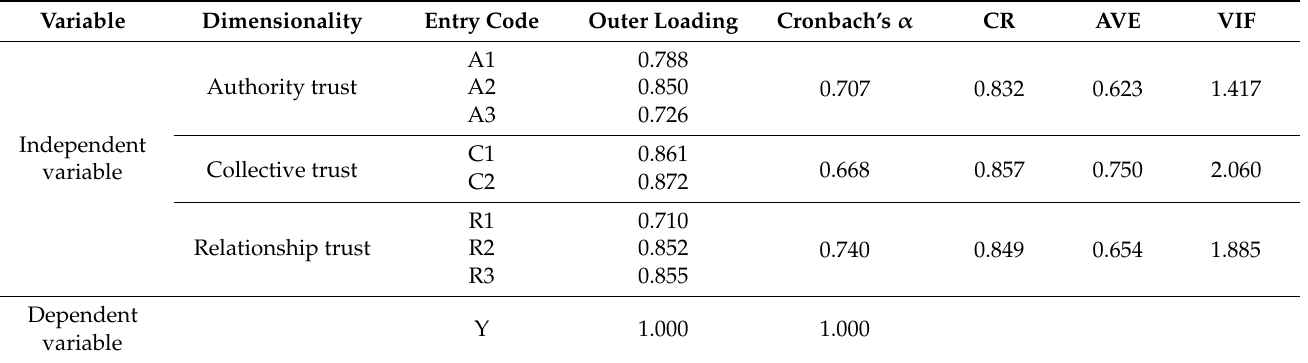
Table 2. Validity test of variables.